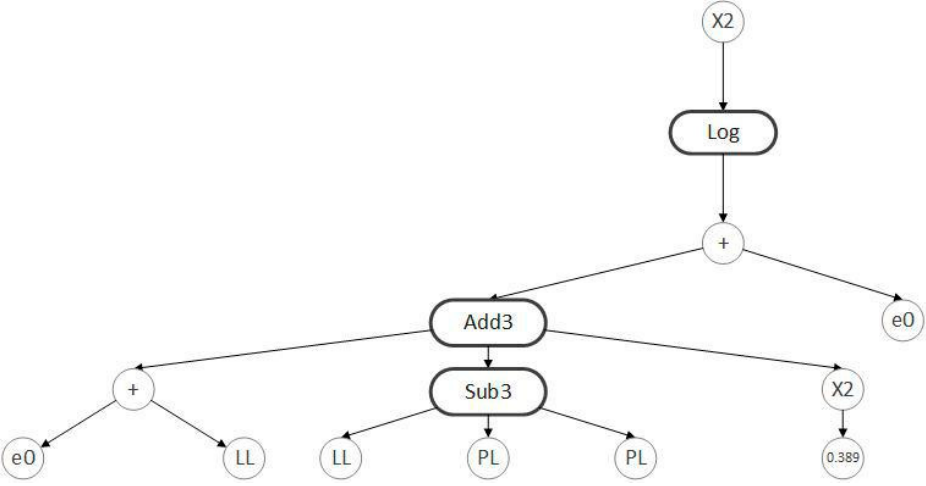
Figure 1. Sample gene expression programming (GEP) model.